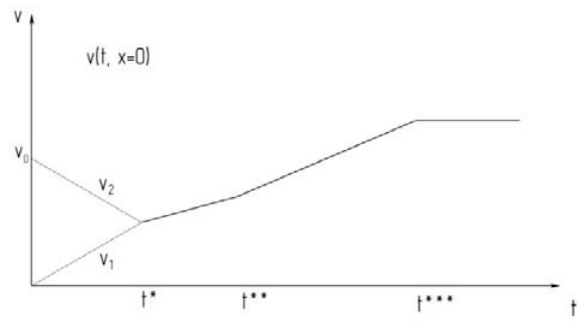
Fig. 8. Dependence of velocity on time.